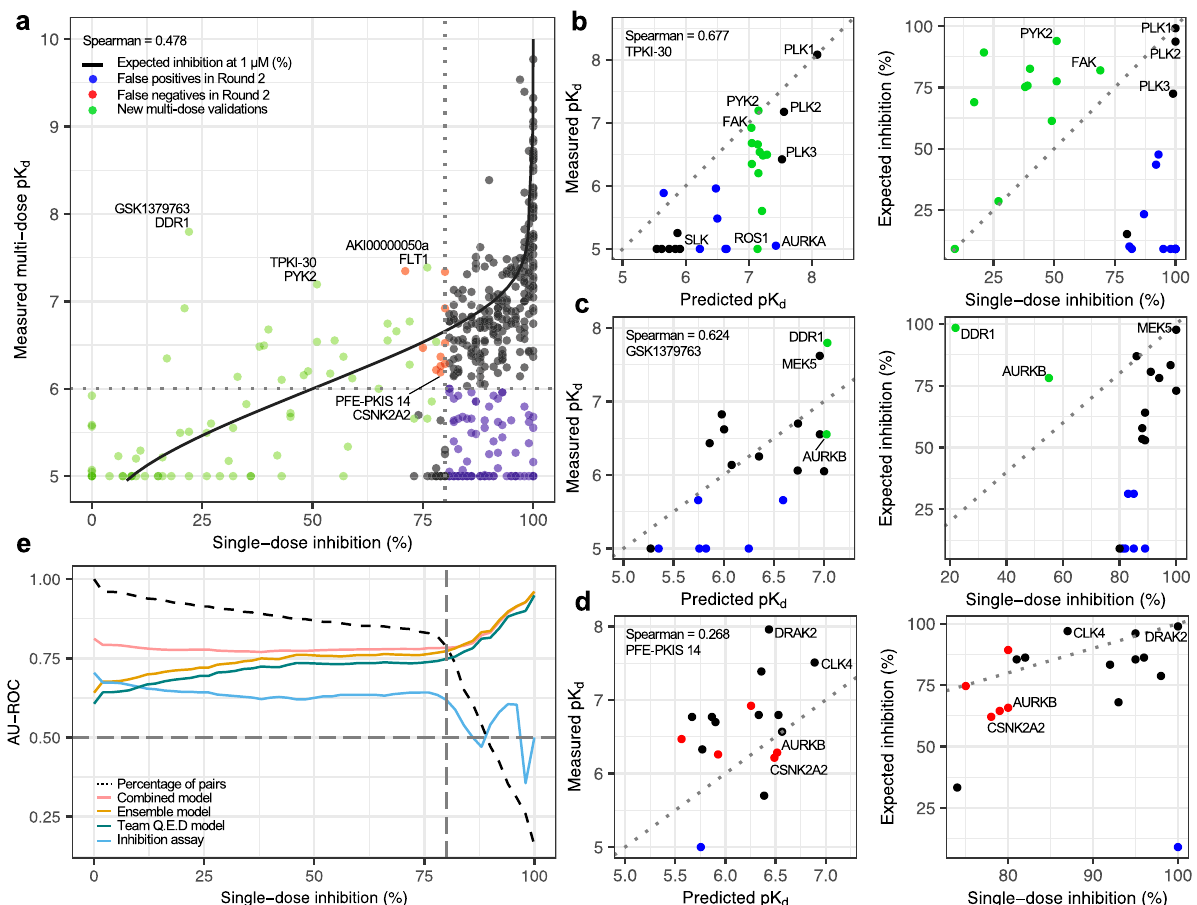
Fig. 8 Machine learning-based kinase activity predictions. a Comparison of single-dose inhibition assay (at 1 µ M) against multi-dose K d assay activities across 475 compound-target pairs (395 from Round 2 and 81 from the post-Challenge experiments). The red points indicate false negatives and blue points false positives when using the cut-offs of pK d = 6 and inhibition = 80% among the 394 Round 2 pairs (including 75 pairs with inhibition >80% but that showed no activity in the dose-response assays, i.e, pK d = 5). The green points indicate the new 81 pairs pro fi led post-Challenge solely based on the ensemble model predictions, regardless of their inhibition levels. The black trace is the expected %inhibition rate based on measured pK d ’ s, estimated using the maximum ligand concentration of 1 µ M both for the single-dose and dose-response assays (see Methods). b – d Multi-dose (left) and single-dose (right) assays for kinases tested with TPKI-30, GSK1379763, and PFE-PKIS14. Green points indicate the new experimental validations based on the ensemble model predictions, whereas black points come from Round 2 data. Blue points indicate false positive predictions based either on predictive models or single-dose testing. e Predictive accuracy of the top-performing ensemble model (average predicted pK d ), top-performing Q.E.D model and single-dose assay (at 1 µ M), when classifying subsets of the 475 pairs into the true activity classes with measured pK d less or higher than 6. The y -axis indicates the area under the receiver operating characteristic (ROC) curve (AU-ROC) as a function of the single-dose inhibition% levels, x -axis the pairs with inhibition > x %, and the dashed black curve the percentage of all pairs that passed that single-dose activity threshold. The combined model trace corresponds to the average of measured and expected inhibition values, where the latter was calculated based on the mean ensemble of the top-performing model pK d predictions (Q.E.D, DMIS_DK and AI Winter is Coming). See Supplementary Fig. 16 for the corresponding analysis with precision-recall (PR) metric, and Supplementary Fig. 17 for the ROC and PR curves for all the 475 pairs. Source data are provided as a Source Data fi le 54